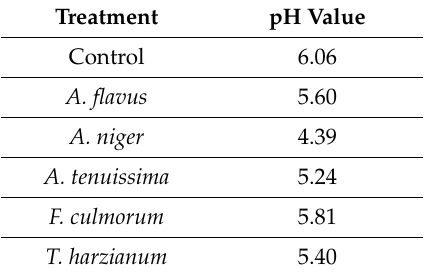
Table 1. E ff ect of fungi on the pH values of powdered wood samples of A. saligna